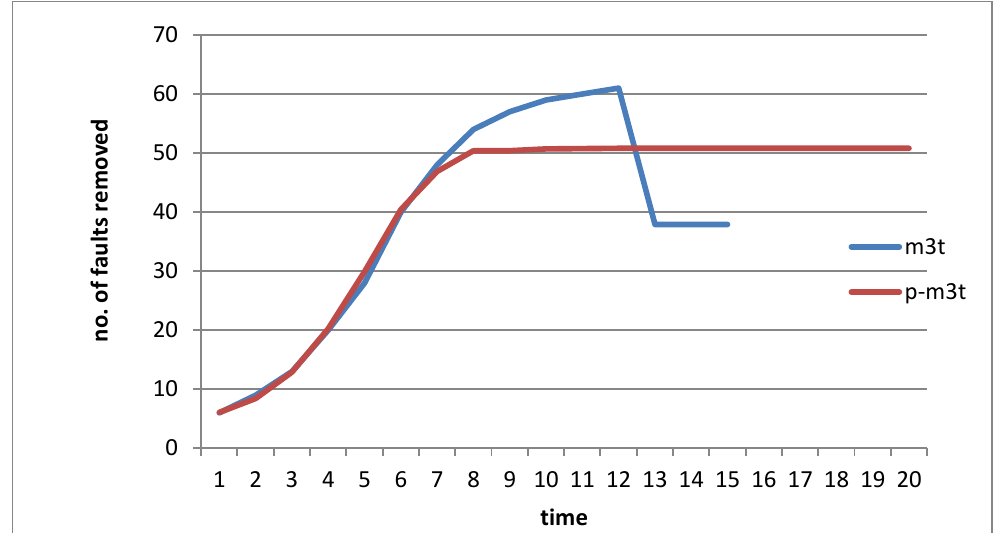
Fig. 4. Goodness of fit curve for the release 3